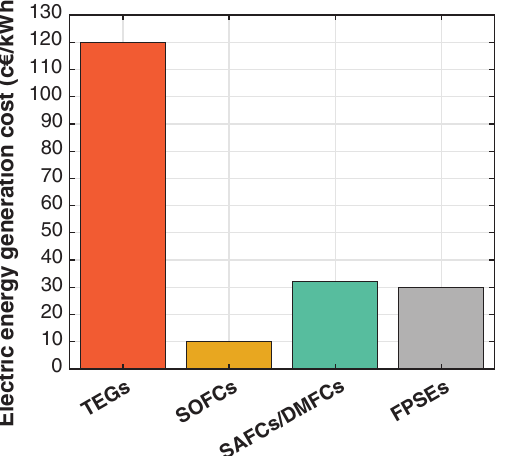
Figure 15. Generation costs of the electric energy by TEGs, FCs and FPSEs.